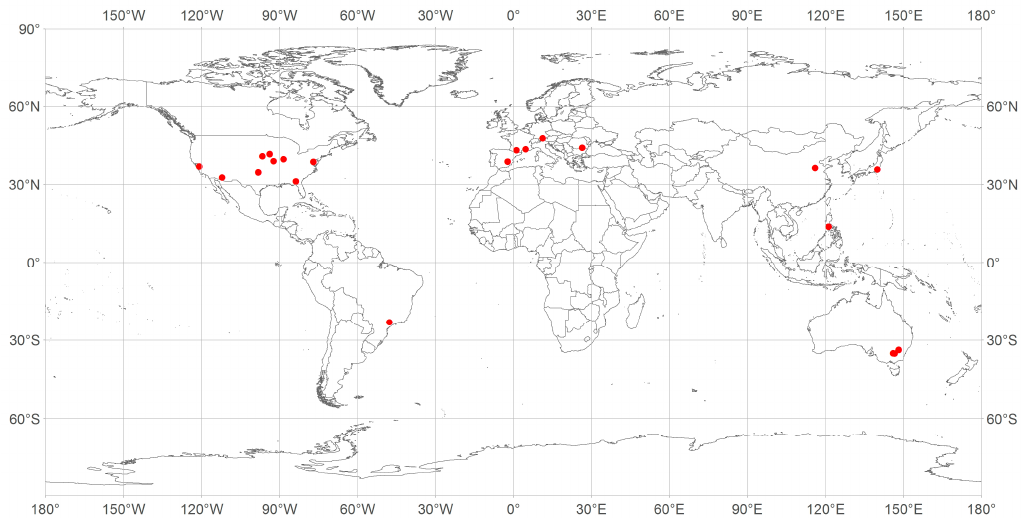
Figure 1. Location of in situ leaf area index (LAI) measurement sites.